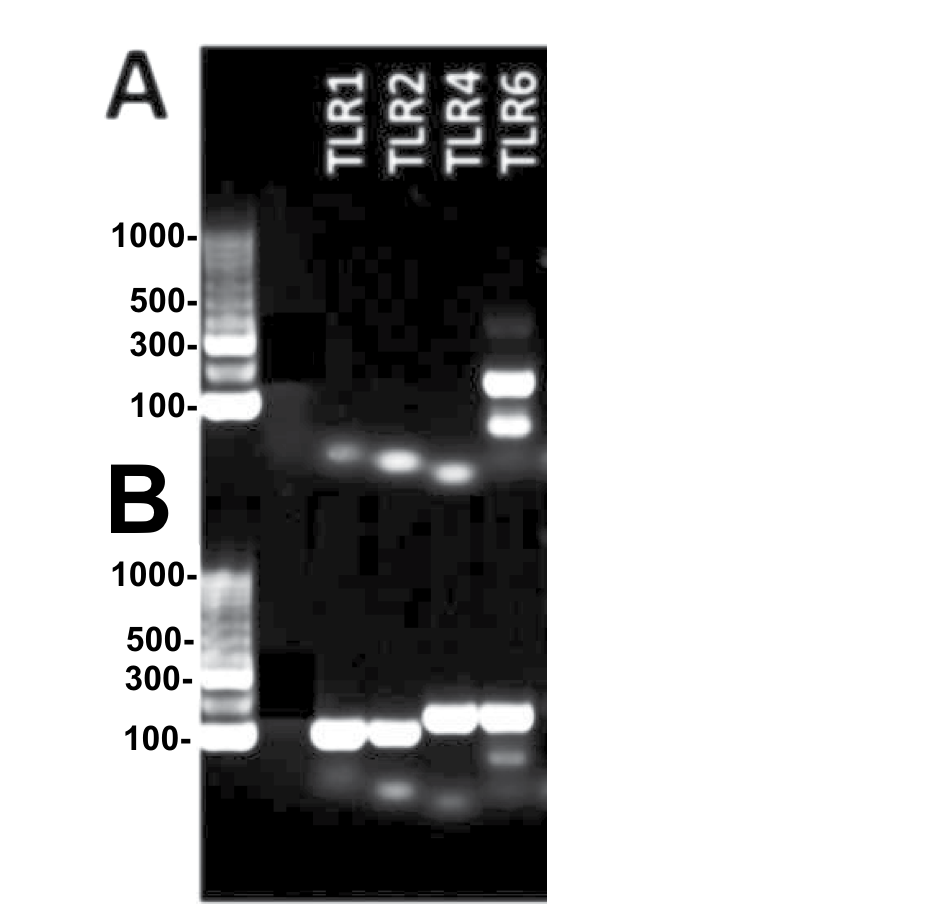
Figure 1. PCR reactions for equine TLR s. Reactions performed with ( A ), DNA sample obtained from e-CAS cells and ( B ), DNA sample obtained from eqT8888 cells. L: Ladder. The picture has been cropped for clarity and conciseness. A picture of the full-length gel is presented in Supplementary Fig.